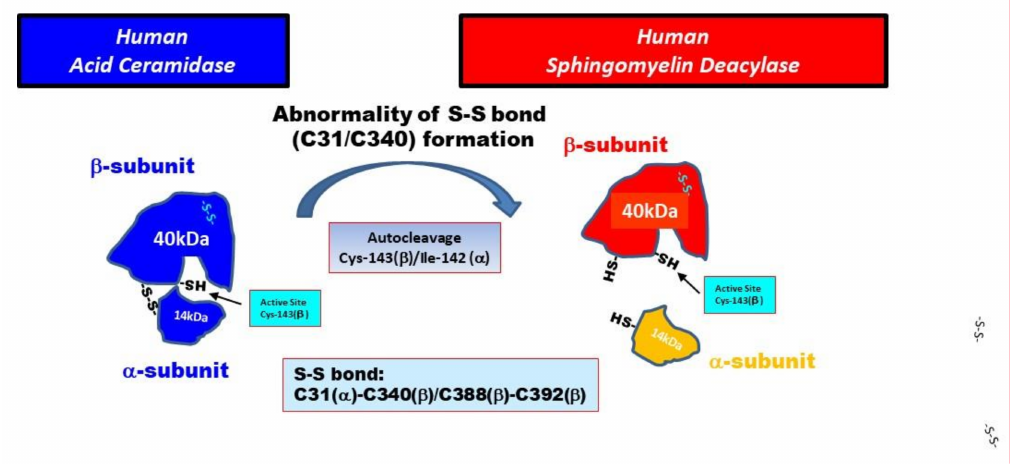
Figure 8. Hypothetical mechanisms involved in the expression of sphingomyelin deacylase in atopic dermatitis (AD)